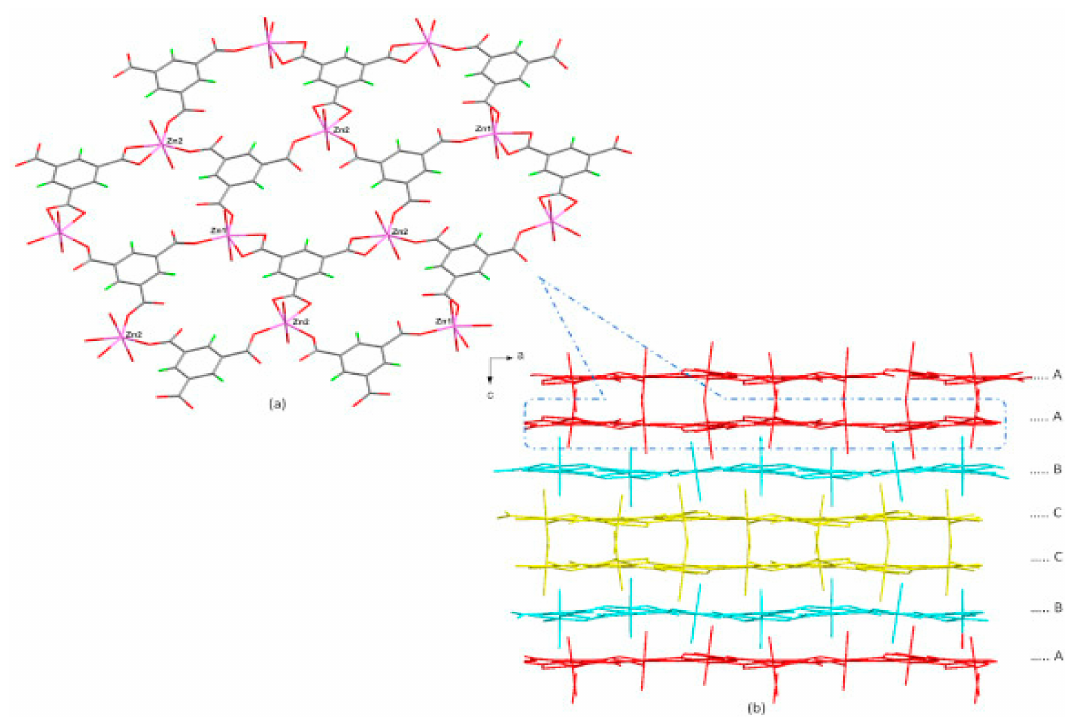
Figure 25. ( a ) A 2D sheet framework of Zn-btc ( b ) stacking of the 2D sheets over one another, through C-H . . . .O bonding. Reprinted with permission from Ref. [58]. Copyright 2019 Elsevier.